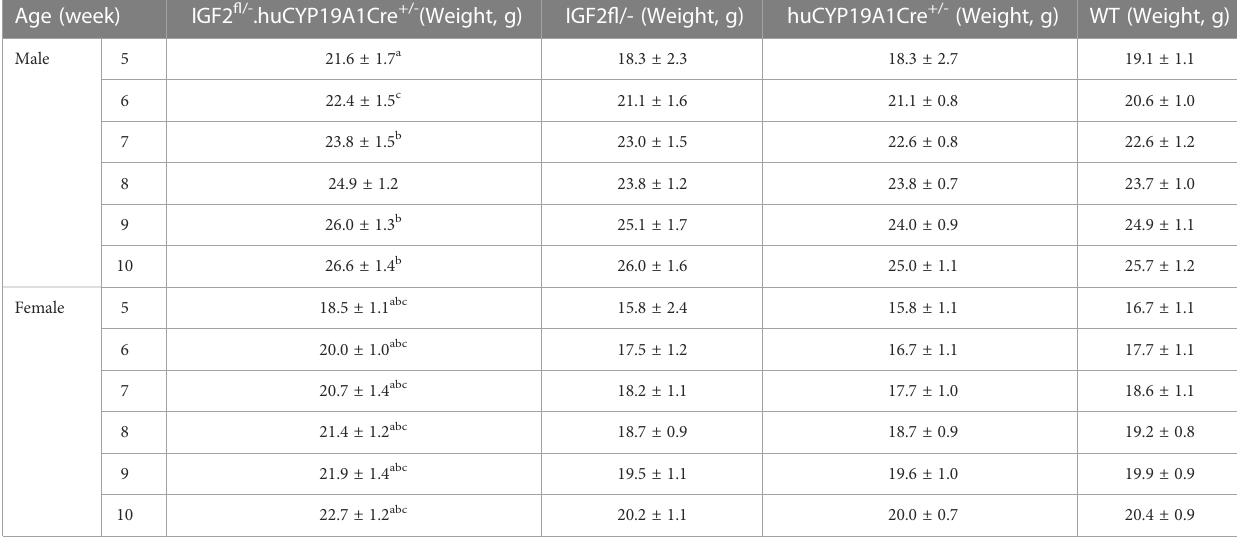
TABLE 4 Comparison of mouse weights at 5-10 weeks old across four genotypes.